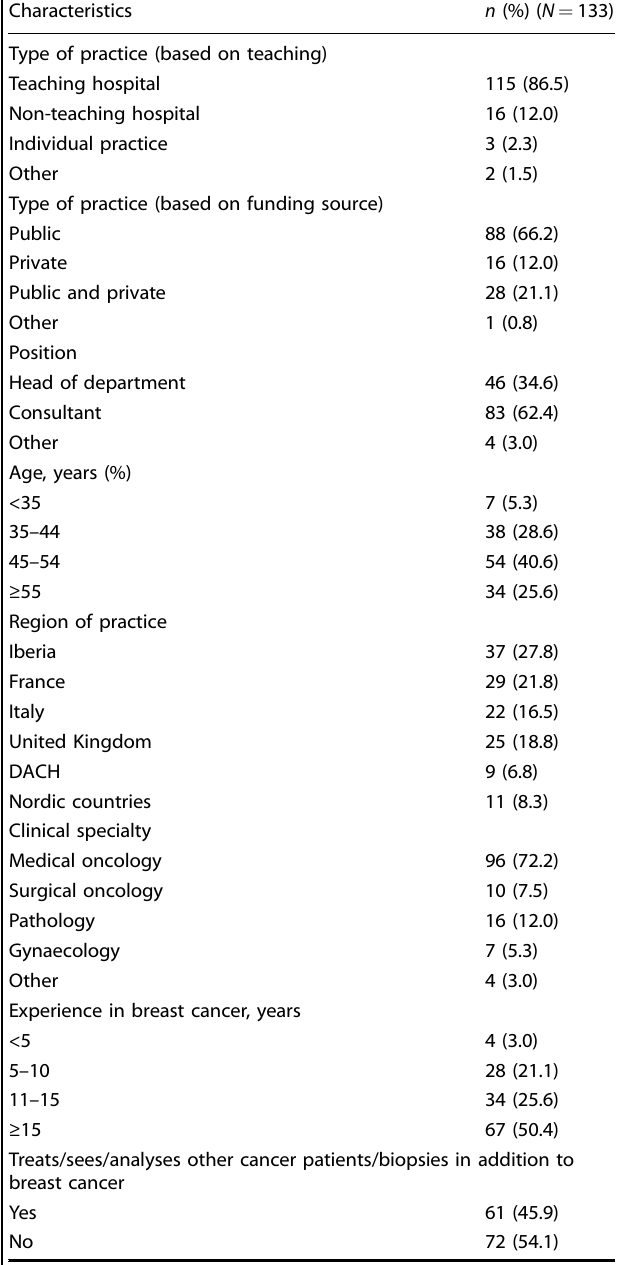
Table 1. Panellists ’ demographics. Table 2. Main criteria reported by panellists to inform the use of BCMS in hospitals with and without BCMS